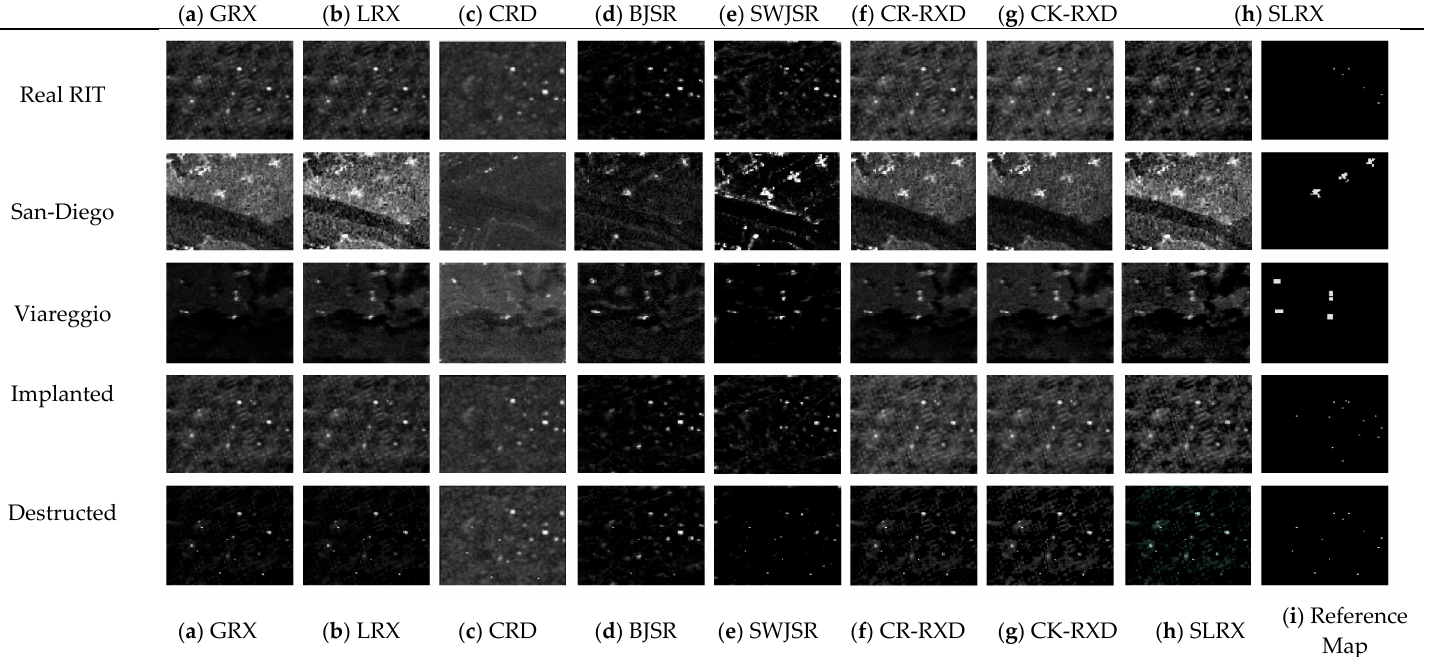
Figure 12. Detection maps of compared algorithms for all datasets: ( a ) GRX detection map; ( b ) LRX detection map; ( c ) CRD detection map; ( d ) Background Joint Sparse Representation (BJSR) detection map; ( e ) SWJSR detection map; ( f ) CR-RXD detection map; ( g ) CK-RXD detection map. ( h ) SLRX detection map; and, ( i ) Reference anomaly map. Table 2. Effect of size of sliding window in the Sliding Window-Based Joint Sparse Representation (SWJSR) detector for all datasets. (The bold one is the higher). Size of Window